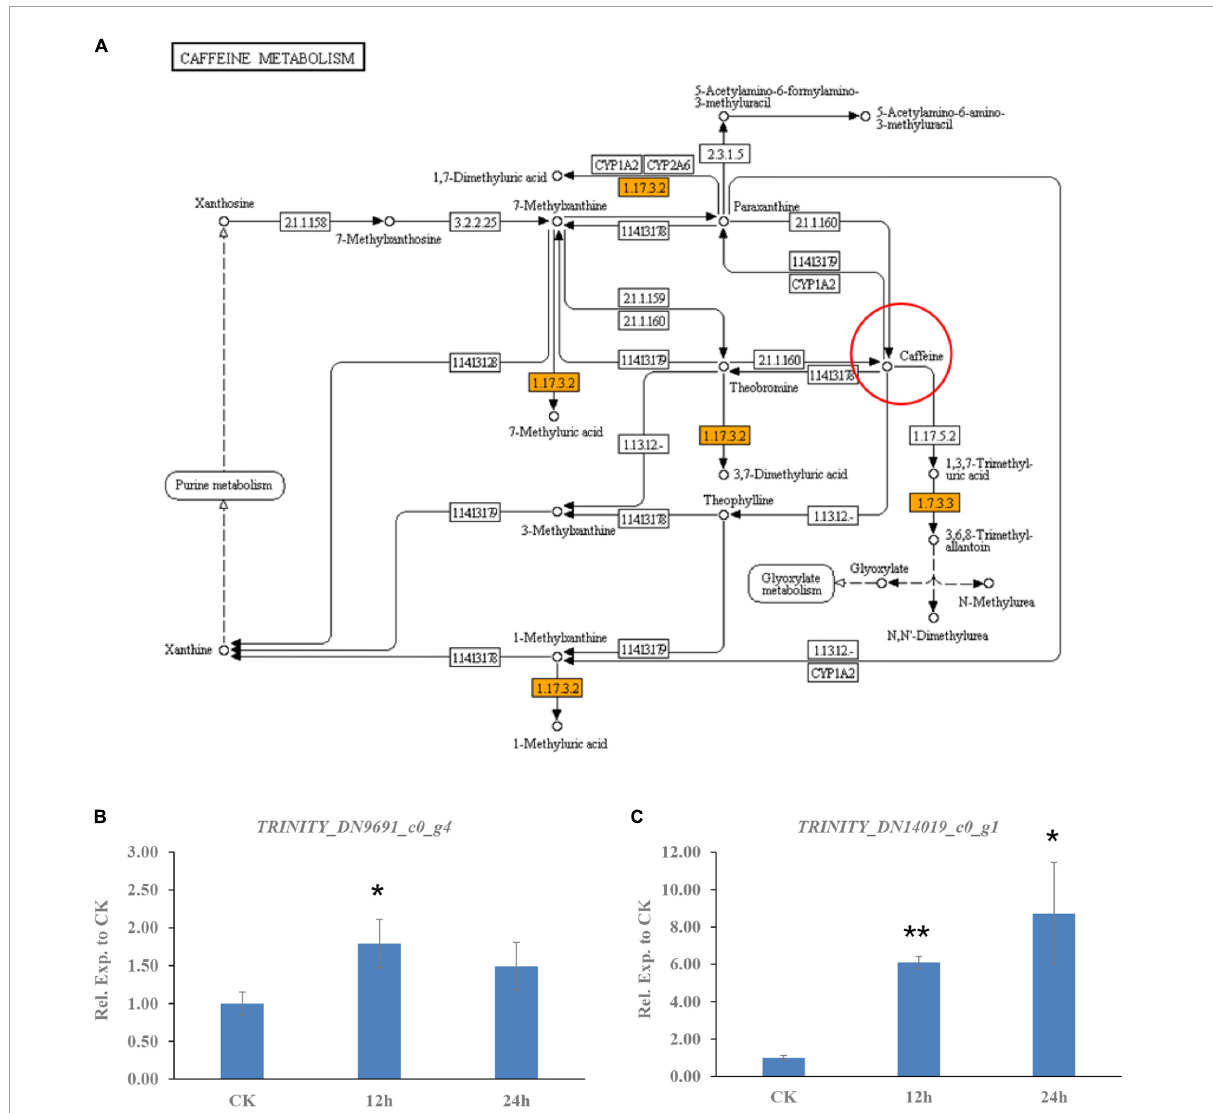
FIGURE3 Caffeine metabolism pathway genes involved in C. camelliae CCA interaction with tea plant. (A) KEGG map of differentially expressed genes in caffeine metabolism pathway. (B) Expression of gene encoding xanthine dehydrogenase (XDH) was induced in C. camelliae CCA during interaction with tea plant. (C) Expression of gene encoding urate oxidase (CcUOX) was increased in C. camelliae CCA during interaction with tea